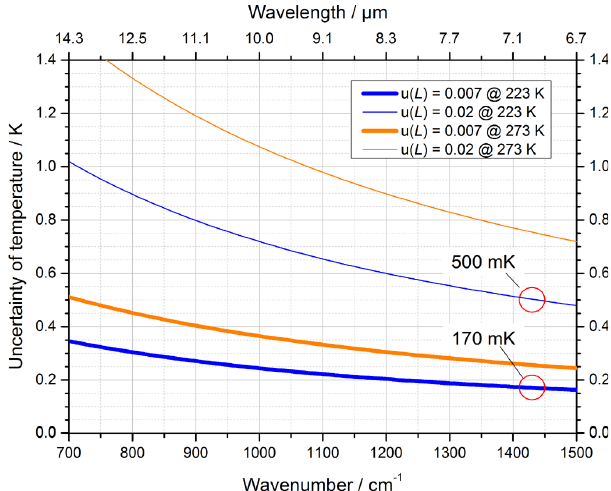
Fig. 1. Relationship between radiance uncertainty and radiation temperature uncertainty for the two extreme operation temperatures of the GBBs ( − 50 ◦ C and 0 ◦ C) and the two uncertainty levels 0.67% and 2% corresponding to GLORIAs target uncertainty of 1% and minimum requirement uncertainty of 3%.